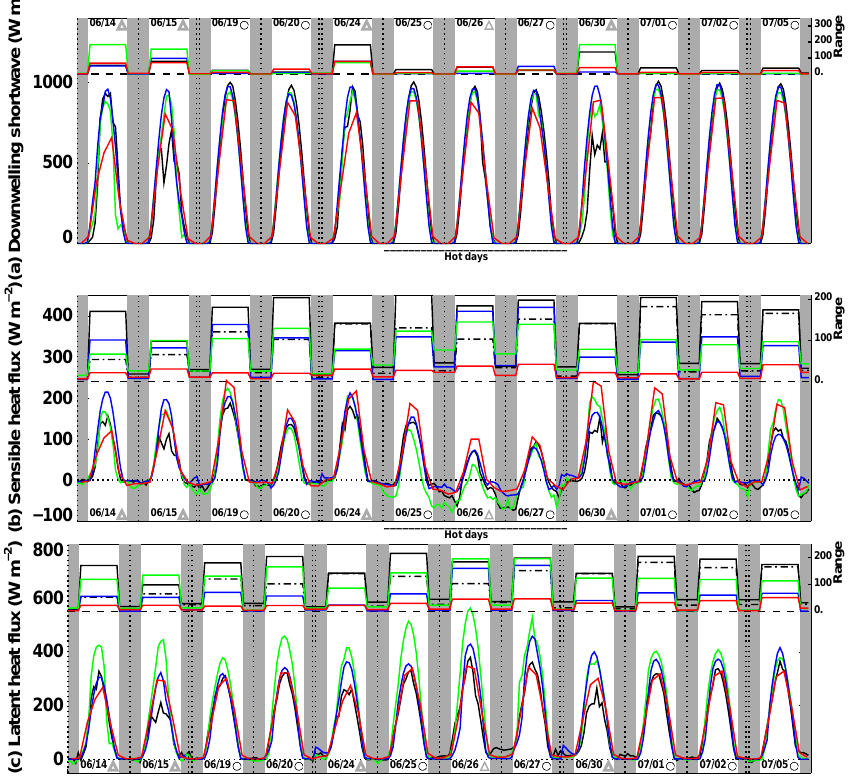
Figure 3. Time series of 24h sequences for the 12 IOPs of (a) surface downwelling solar flux, (b) sensible heat flux and (c) latent heat flux, measured over surface sites in black, simulated by ARPEGE in blue, by AROME in green and ECMWF in red with the mean value (left axis) and the maximum horizontal range (right axis), computed as the difference between the maximum value and the minimum value for all sites or all grid points of a given model but averaged respectively over day and night; for observations both the range computed with all sites (full line) or by removing the forest stations (dash-dotted lines). The vertical grey shading marks the night-time. Two consecutive vertical dashed lines indicate interruption in the days. Note that for ARPEGE, due to the different behaviour of ARP1 and ARP3, only ARP2 is plotted as the mean while the spatial variability is computed with the three